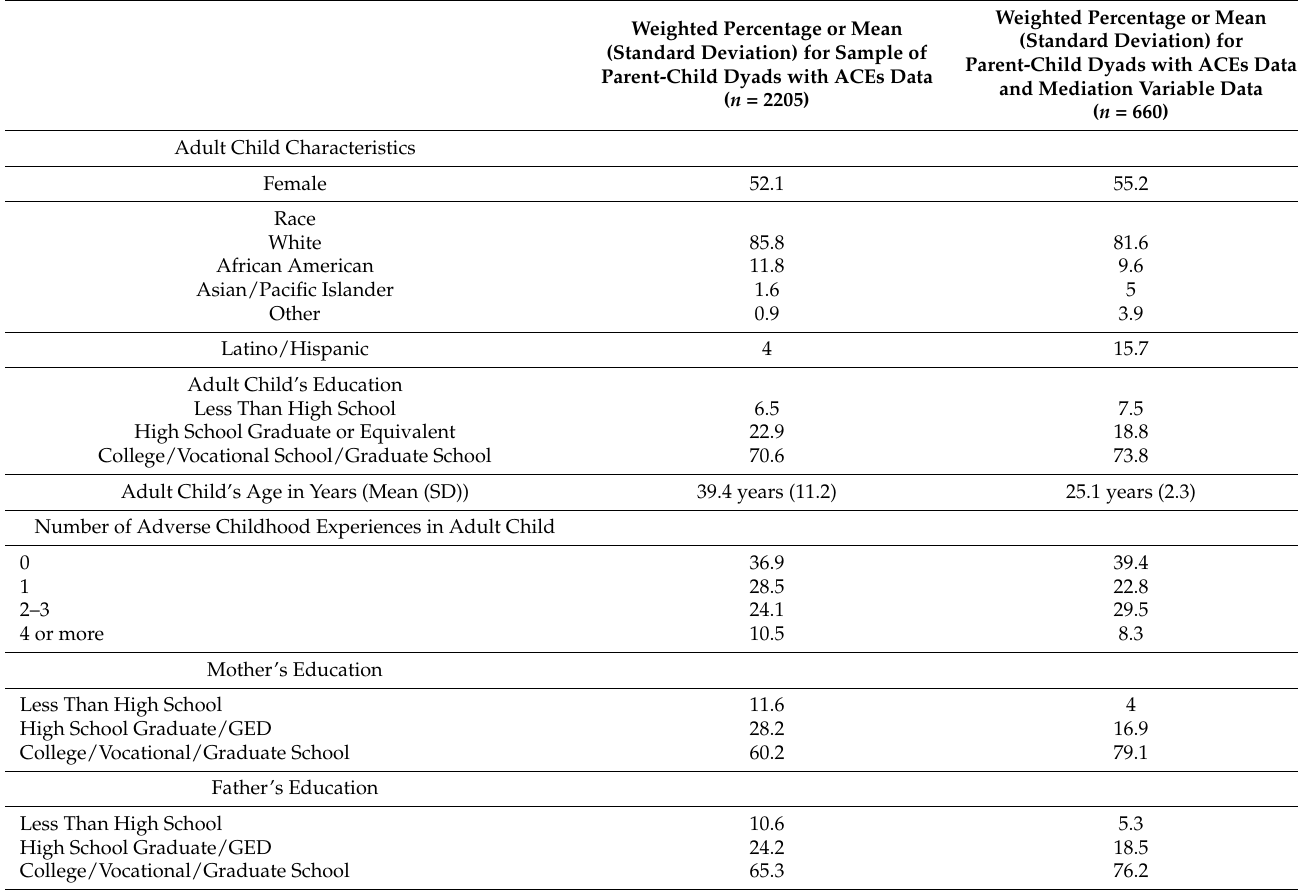
Table 2. Sample Characteristics for Parent-Child Dyads in Childhood Retrospective Circumstances Study. Weighted Percentage or Mean (Standard Deviation) for Sample